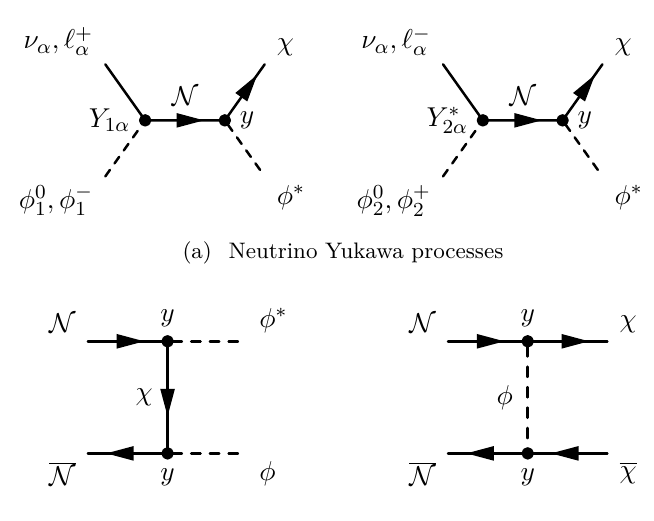
Figure 2 . Processes responsible for the dark matter production considered in this